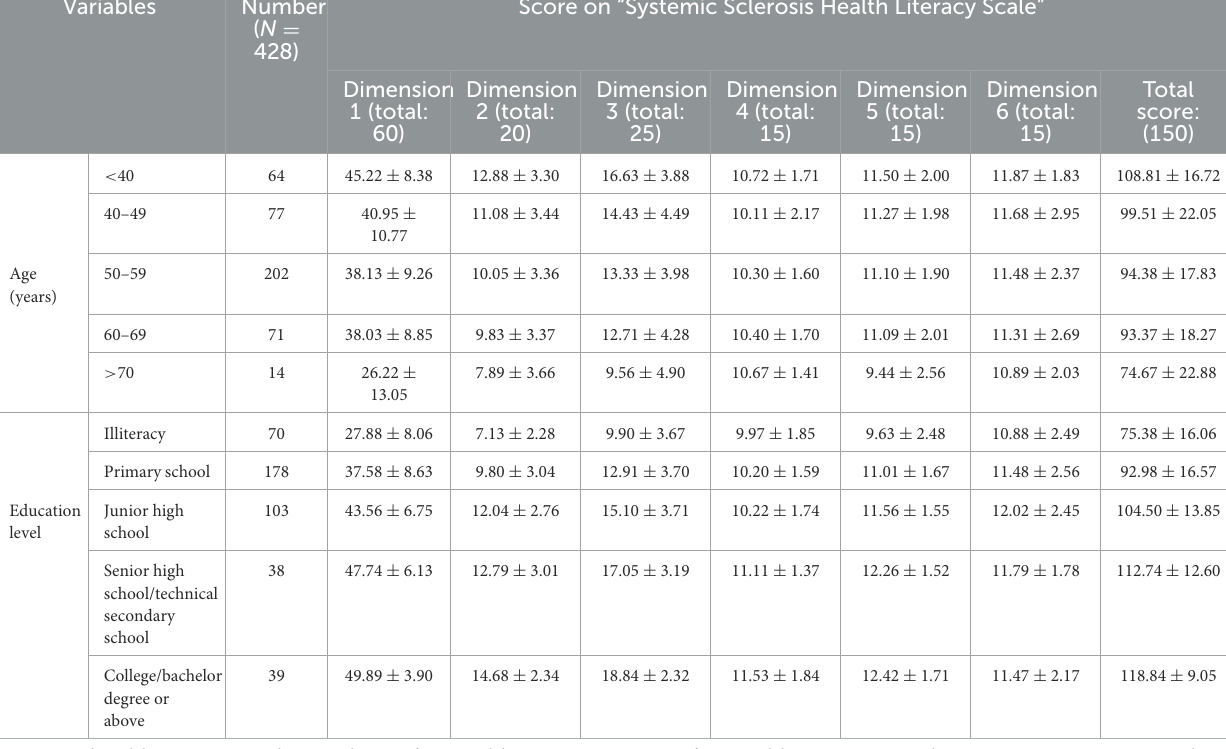
TABLE 6 Health literacy scores of patients of different ages and education levels. Variables Number